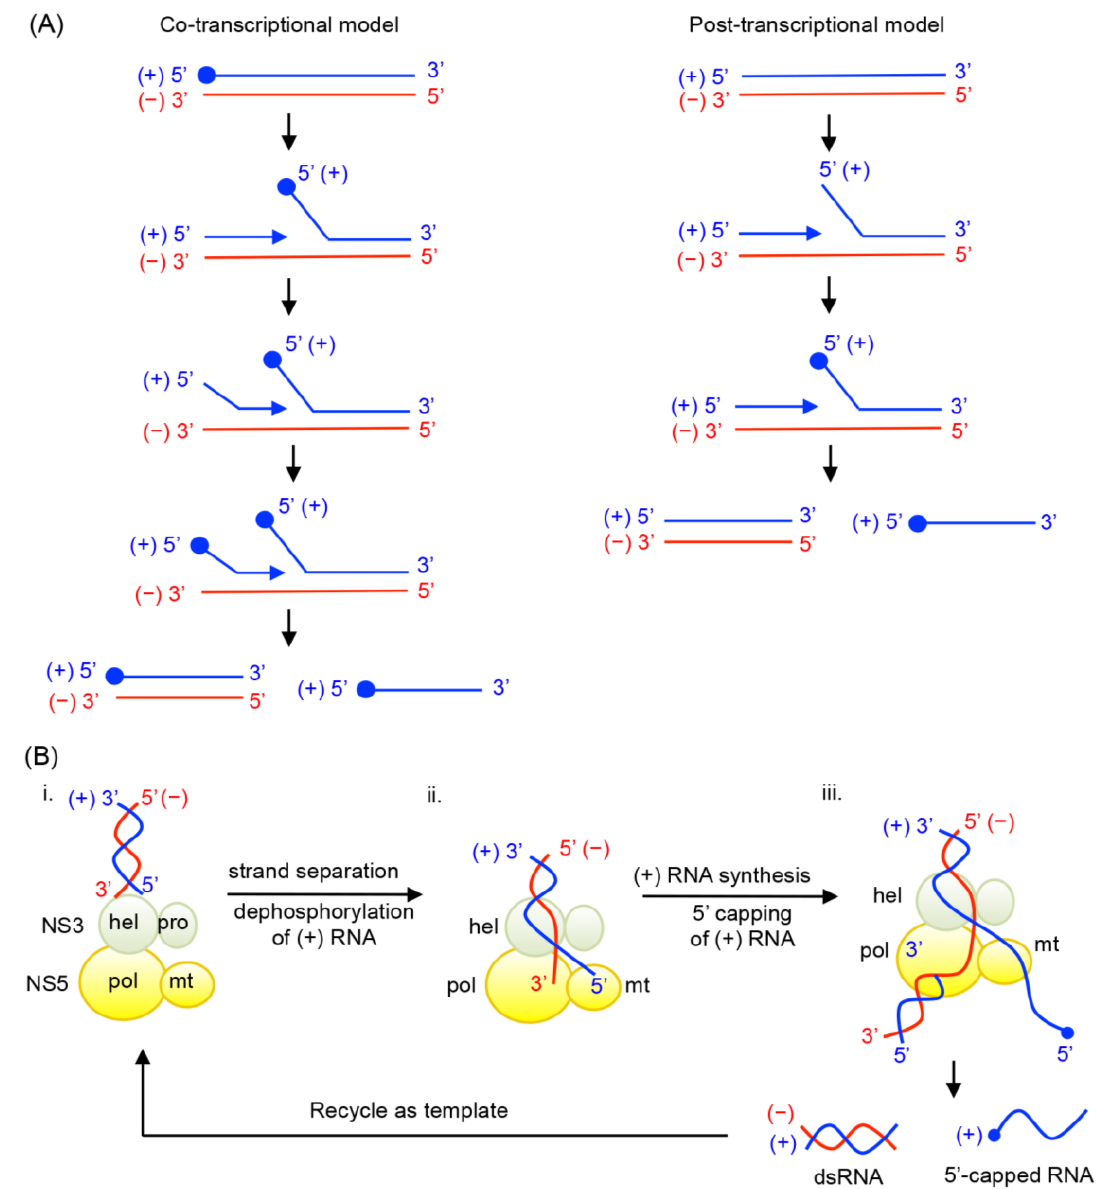
Figure 4. Possible mechanisms of coordination between RNA synthesis and 5′-RNA capping. ( A ) Two possible mechanisms are proposed for 5′-RNA capping for (+) sense RNA. In a co-transcriptional model, 5′-RNA capping occurs co-transcriptionally while nascent (+) sense RNA is being synthesized from dsRNA replicative form. After a short stretch of (+) sense RNA being synthesized, the 5′ end of the nascent (+) RNA would be dephosphorylated by NS3 helicase, and capped and methylated by NS5 MTase. The cap structure is depicted with a closed circle. The 5′-capped (+) sense RNA would then be continuously synthesized until the entire (−) strand is copied. Upon completion of a cycle, a dsRNA containing a capped (+) strand and a capped (+) RNA are synthesized. In a post-transcriptional model, 5′-RNA capping occurs on the fully synthesized (+) strand RNA. Following strand separation of dsRNA, the (+) sense RNA could be dephoshphorylated by NS3 helicase, and capped and methylated by NS5 MTase. Upon completion of a cycle, a dsRNA and a capped (+) RNA are synthesized. ( B ) Coordination of RNA synthesis and 5′-RNA capping by flavivirus NS3 and NS5 in the post-transcriptional model. ( i ) NS3